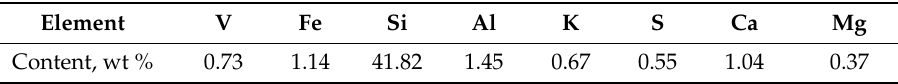
Table 1. Main chemical compositions of raw sample (wt